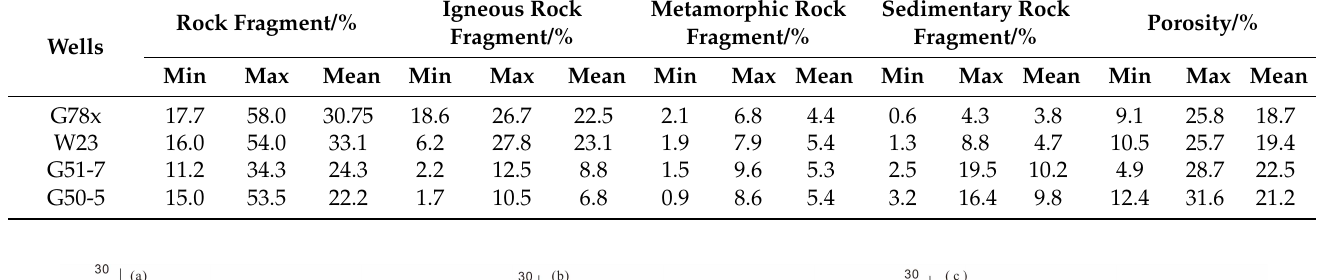
Table 3. Statistics of rock fragment types and porosity of samples from four wells of Ek1 member in the Wang Guantun Area.